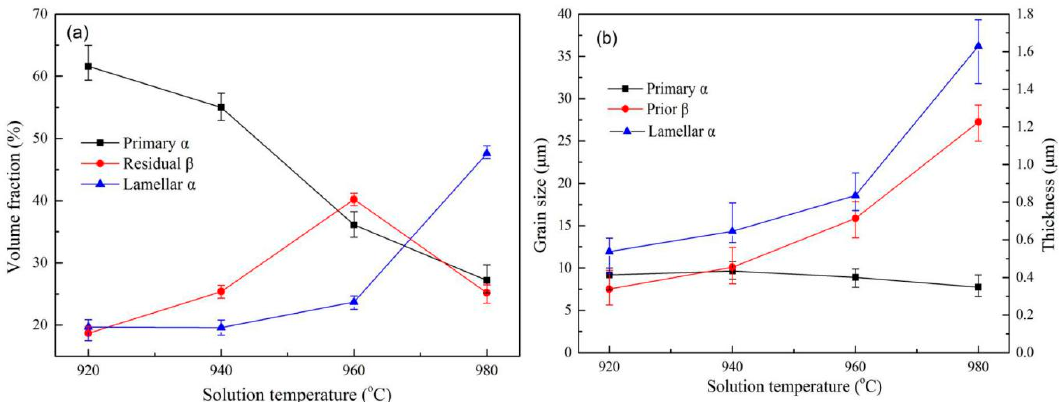
Figure 4. Microstructure statistics ( a ) volume fraction of α , β phase under different solution temperature and ( b ) grain size and thickness of α , β phase under different solution temperature.